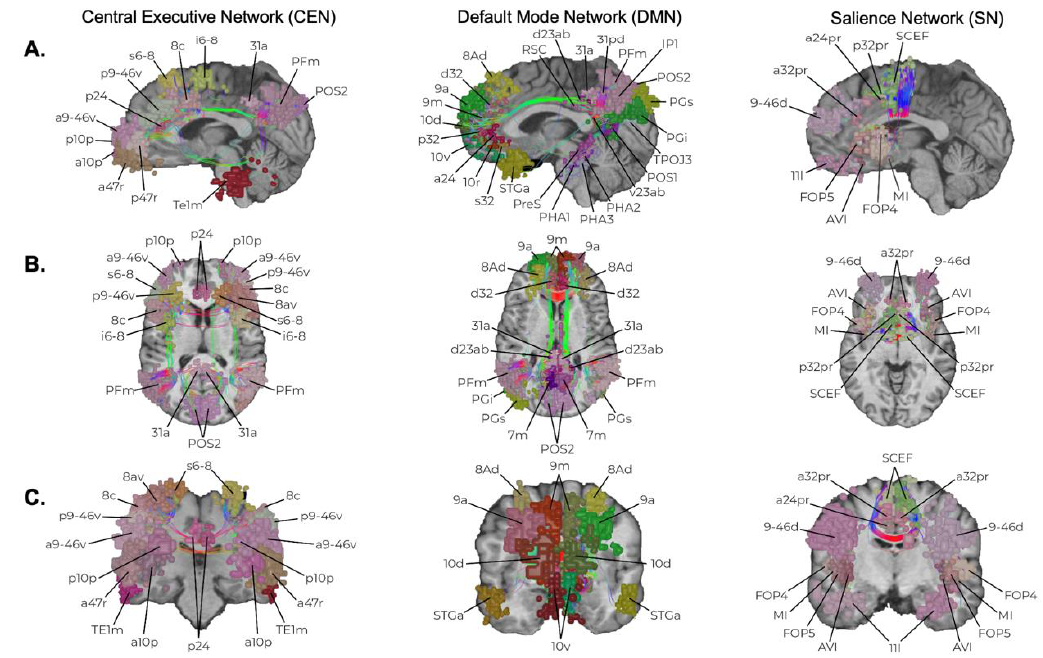
Figure 3. Cognitive Control Networks. The anatomic locations of the Default Mode Network (DMN), Salience Network (SN), and Central Executive Network (CEN) are presented in sagittal ( A ), axial ( B ), and coronal slices ( C ). Individual parcellations are indicated according to the established Glasser Parcellation Scheme of the Human Connectome Project [24] based on network affiliation [25] .